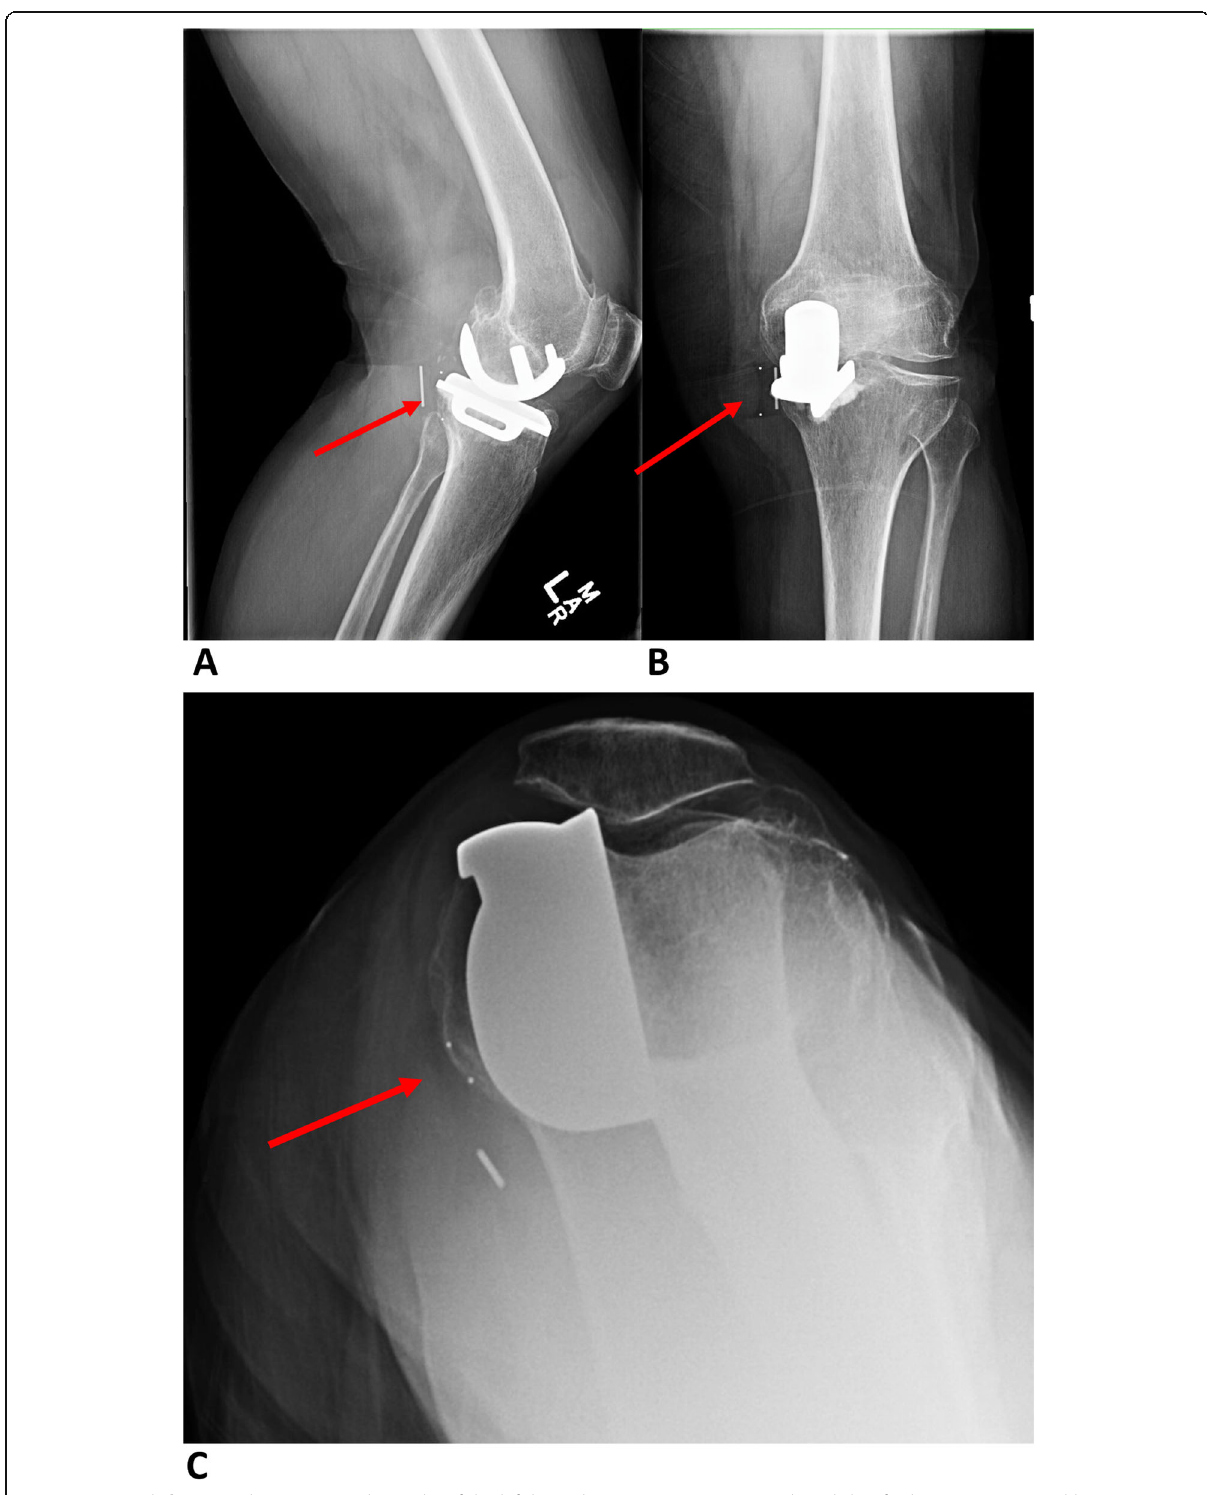
Fig. 1 ( a ) Lateral, ( b ) AP, and ( c ) sunrise radiographs of the left knee demonstrating a cemented medial Oxford unicompartmental knee arthroplasty with posteromedial dislocation of the polyethylene mobile bearing insert. There is also significant lateral and patellofemoral osteoarthritis with associated anterior femoral and patellar